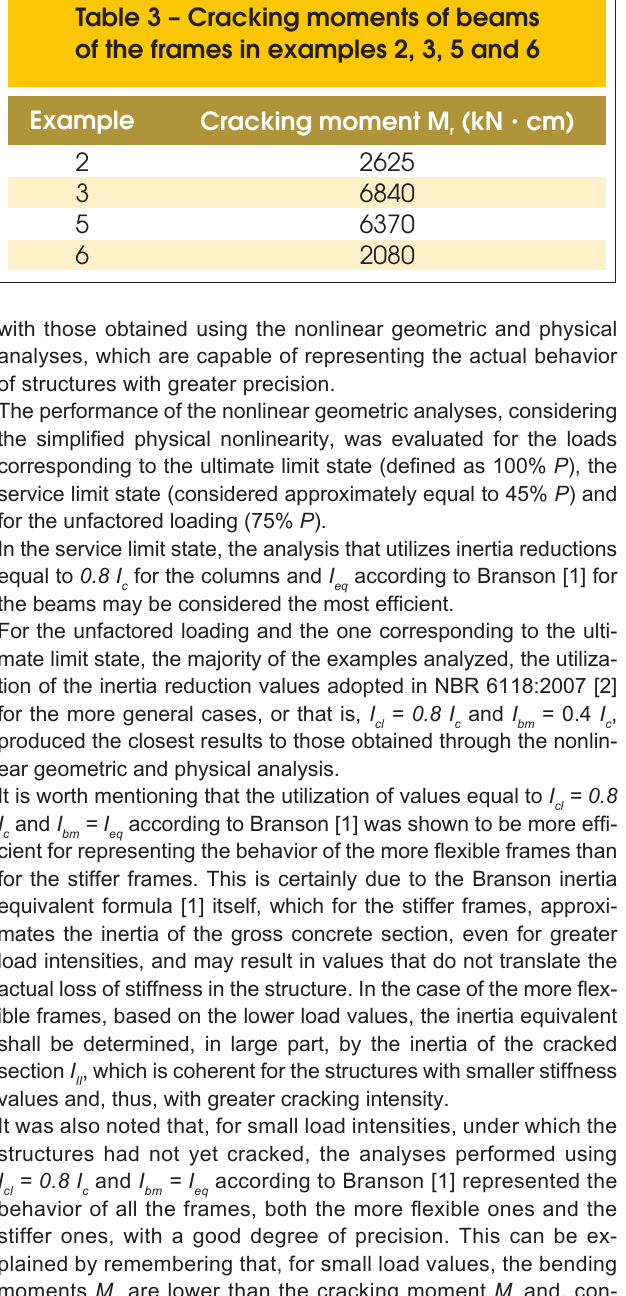
Table 3 – Cracking moments of